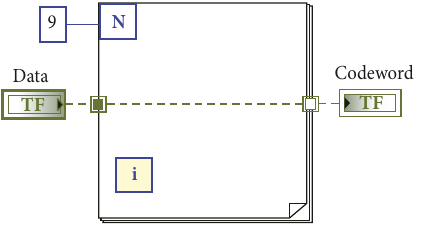
Figure 16: Schematic depiction of the description of a 9 x repetition encoder using HLS using just a for-loop without any logic specific to the code.